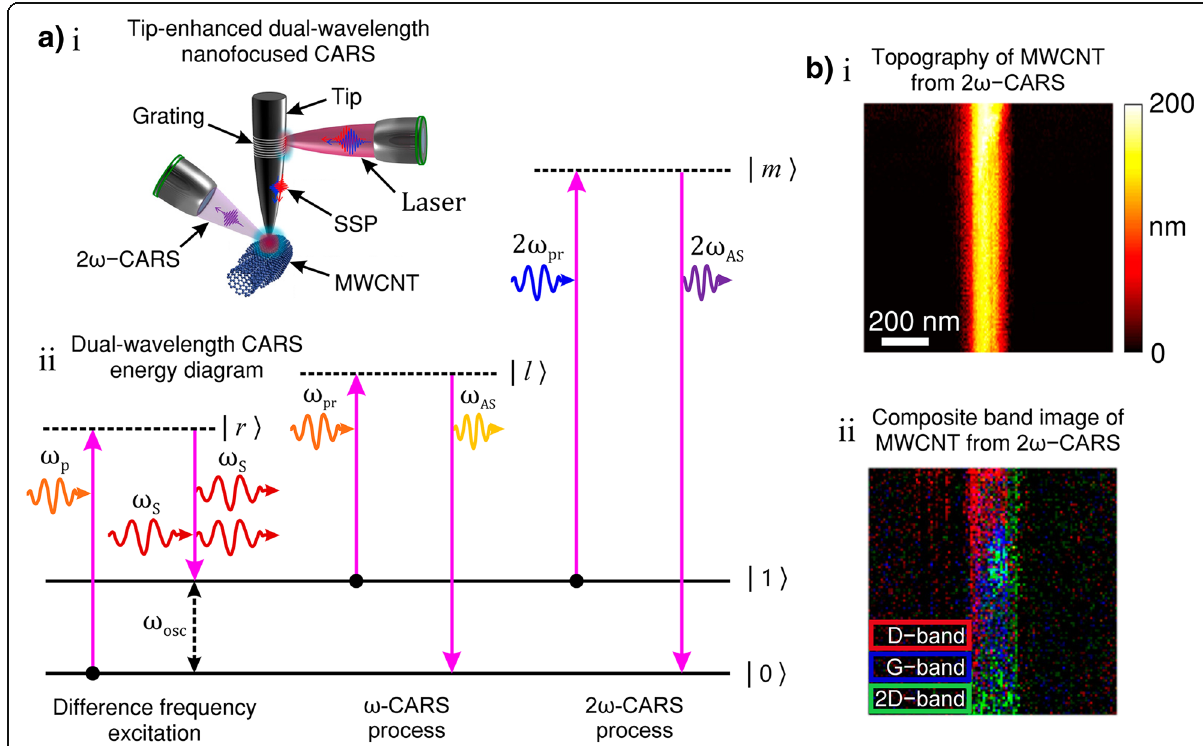
Fig. 8 a i Illustration of tip-enhanced dual-wavelength nanofocused CARS on a multi-walled carbon nanotube (MWCNT). a ii Energy diagram for ω -CARS and 2 ω -CARS. When the difference frequency between pump and Stokes light matches the vibrational mode of the molecule, it is resonantly excited. When ω and 2 ω -probe light is simultaneously incident within the dephasing time, ω - and 2 ω -CARS photons are respectively generated. b i Simultaneous topographical 2 ω -CARS imaging of a MWCNT. b ii Composite image of three 2 ω -CARS images of the MWCNT using the 2 ω -CARS spectrum from D- (red), G- (blue) and 2D- (green) bands. Reprinted with permission from